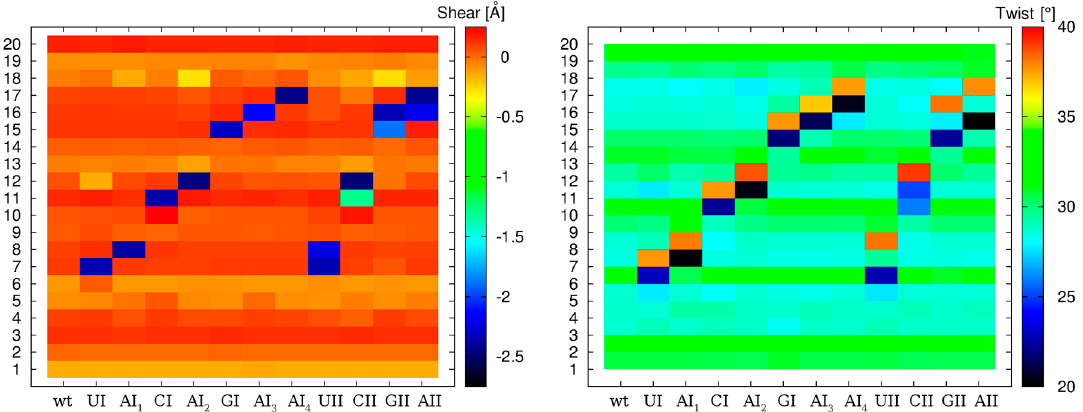
Figure 3. Averaged values of shear ( left ) and twist ( right ) calculated for twelve selected systems. Shear was calculated for each base pair, the twist was calculated for each base pair step (residue numbers are on the y -axis). Data were averaged along the whole trajectory.